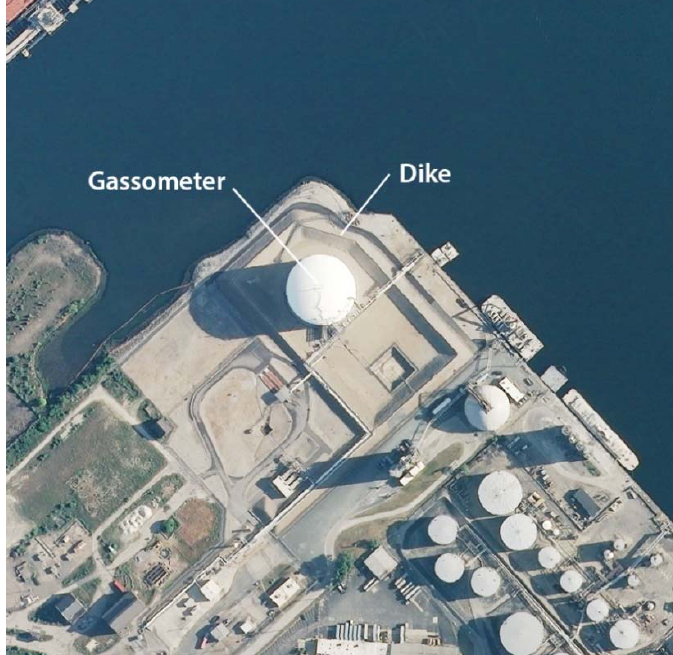
Figure 14. Example of micro ‐ topographical condition. The gasometer is protected by an armored concrete dike that is not ‘visible’ to the ocean model. Determining inundation extents without accounting for this dike will lead to misleading results. Image: Authors (Air photo: RIGIS).